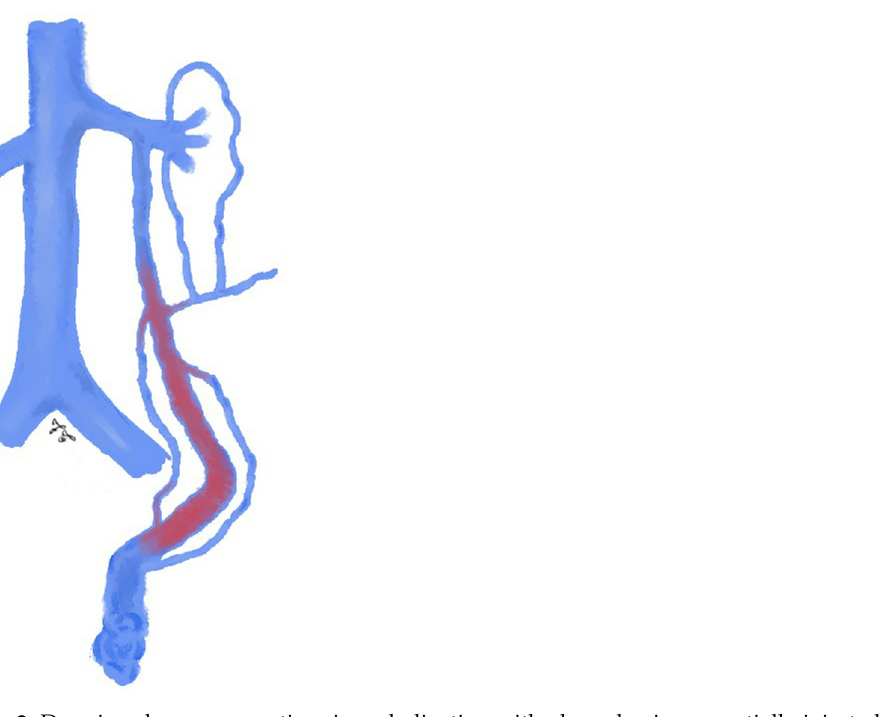
Figure 2. Drawing shows spermatic vein embolization with glue: glue is sequentially injected and pushed into the distal intrapelvic segment of the gonadal vein as well as into the collaterals; injection should be stopped before the pampiniform plexus is reached.